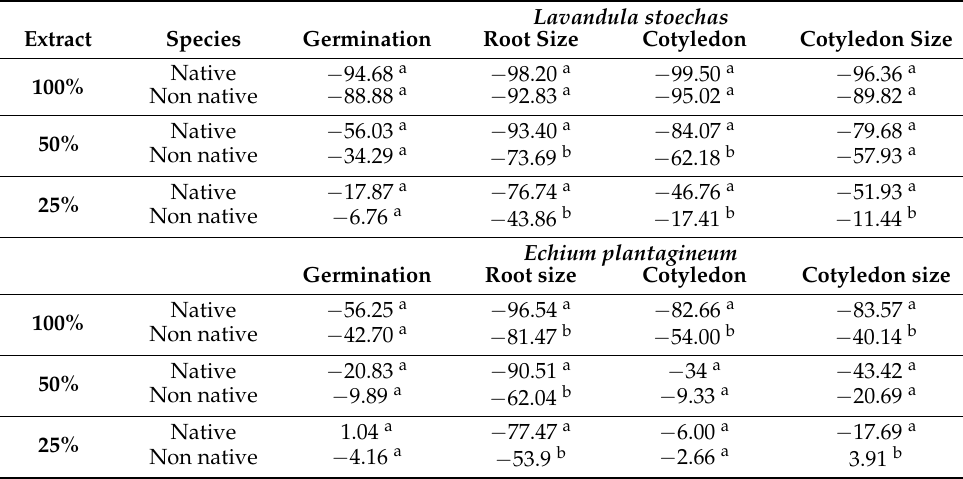
a,b : Lowercase letters indicate significant differences between native and non-native species (Mann-Whitney test, p >